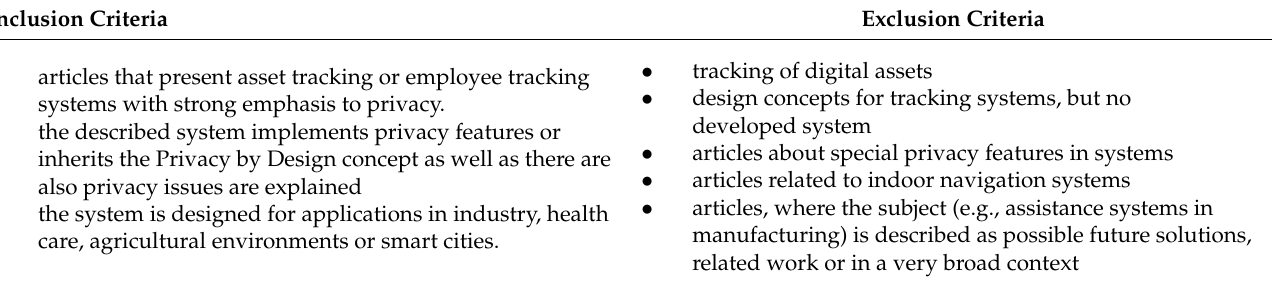
Table 2. Overview from inclusion and exclusion criteria for this